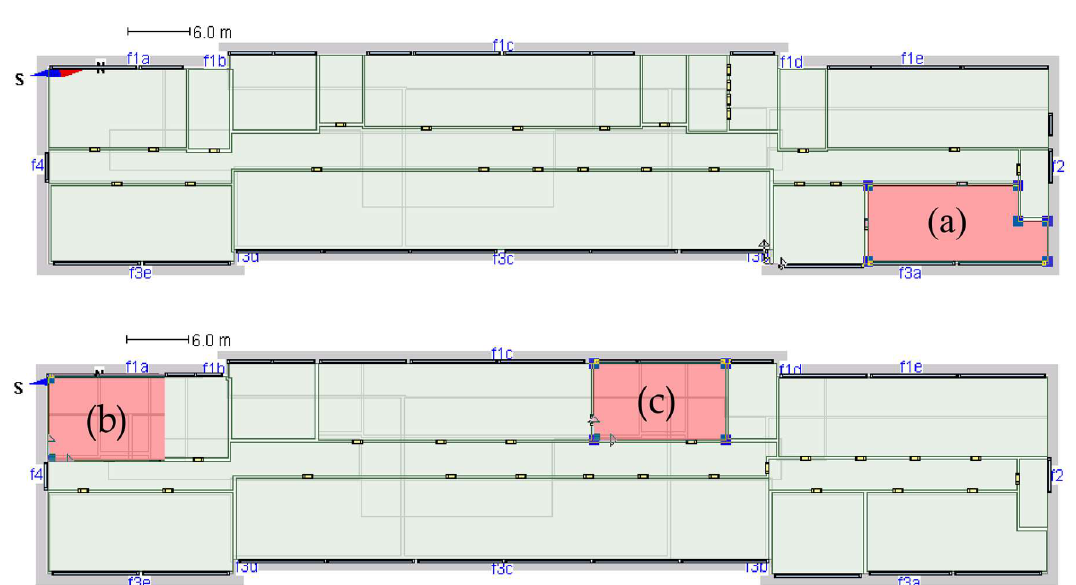
Figure 6. The actual rooms in the first floor plan.